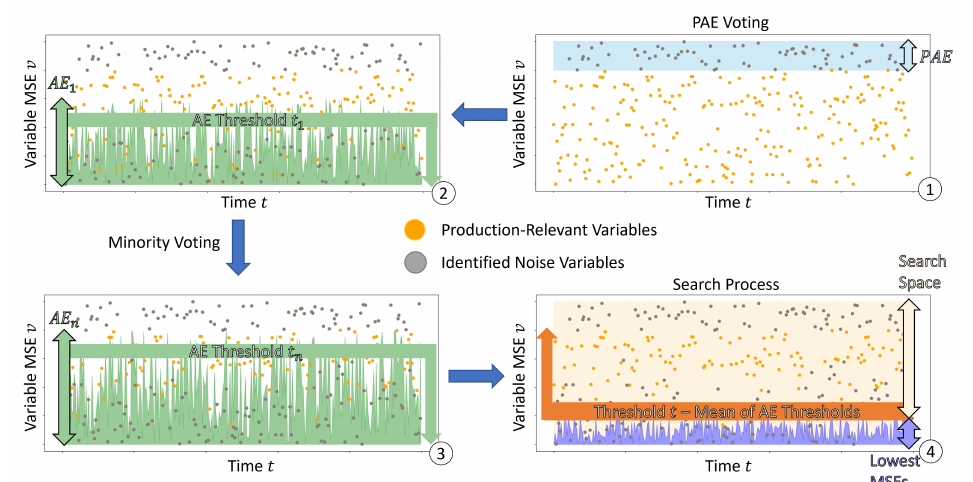
Figure 3. Illustration of AE-Ensemble Utilization. (1) Production AE (PAE) removes outliers from production data to clean the pData . (2–3) Each AE reconstructs the events encompassed in pData differently and flags events as noise (minority voting). (4) The search process starts from the mean of all AE Thresholds and increases until only the computed N production-relevant variables are